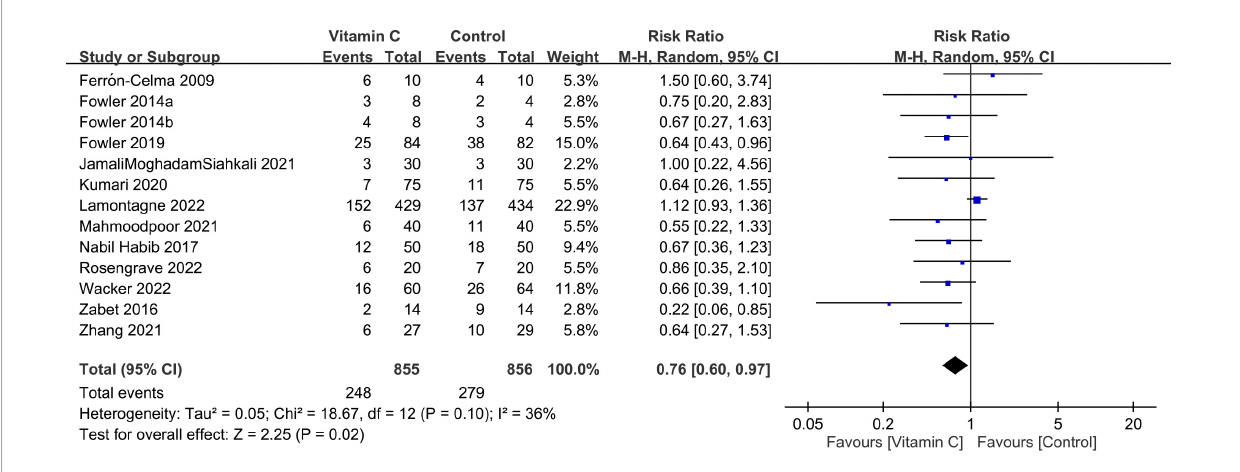
FIGURE3 Forest plot comparing risk of mortality between intravenous vitamin C and control groups. M-H, Mantel-Haenszel; CI, confidence interval.